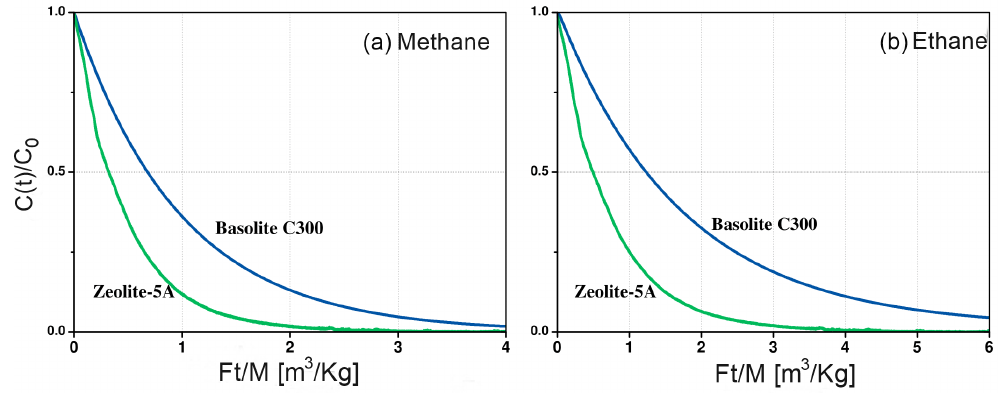
Figure 4. Comparison of the adsorbent capacity of Zeolite 5A and Basolite ® C300 of ( a ) methane and ( b ) ethane in helium at 298K, and